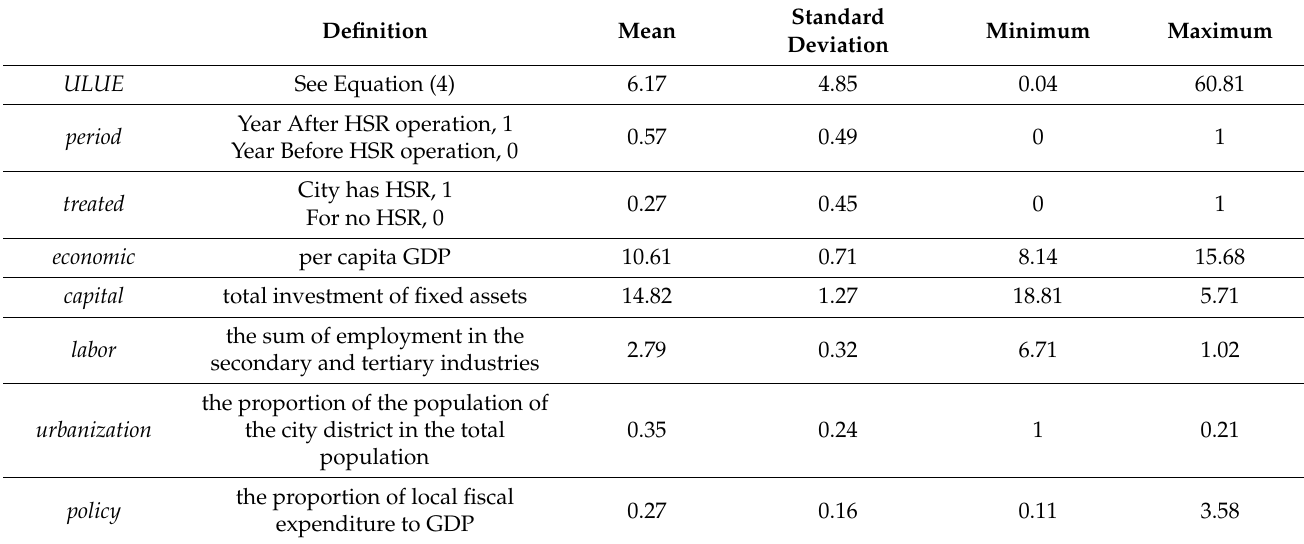
Table 1. Variables definition and descriptive